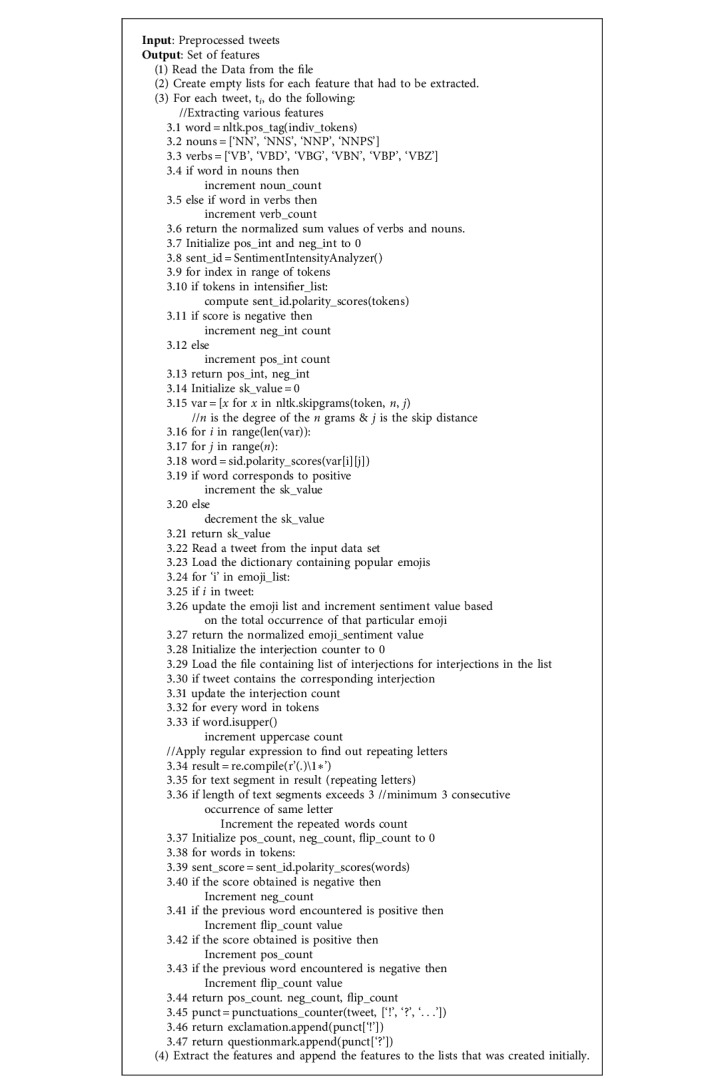
Feature selection.